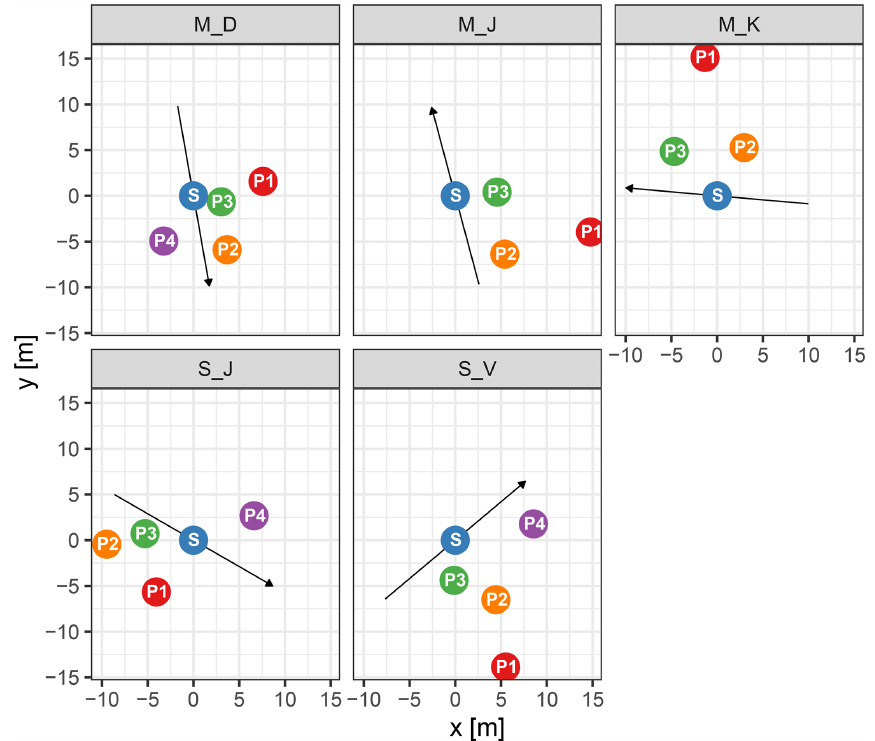
Figure 2. Schematic maps of the five sites. “P” stands for piezometer with the corresponding number, while “S” stands for stream and is located at (0, 0). The arrows point along the direction of streamflow. The coordinates are relative distances to the stream water-level sensor (positive y axis points north).